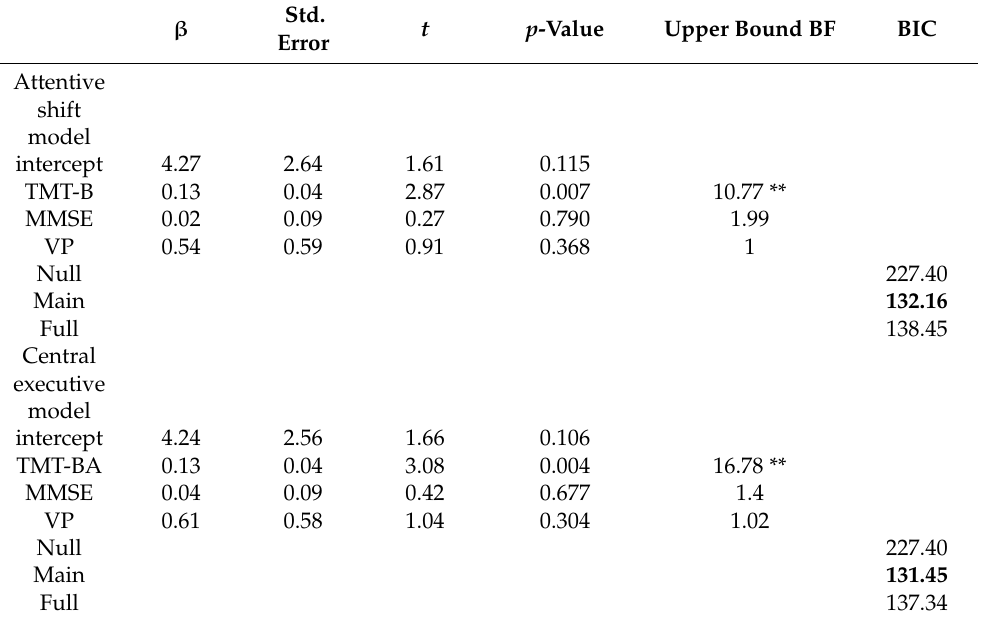
Table 2. Results of the linear regressions on fall risk and Bayesian